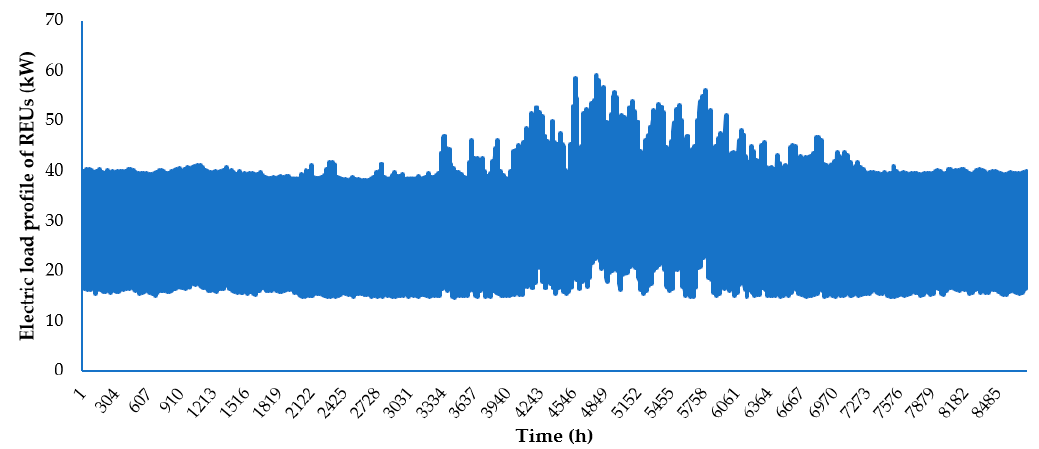
Figure 8. Electricity load profile of a multi stair residential building located in New York, USA [Note: REU—Residential electricity users; USA—United States of America).